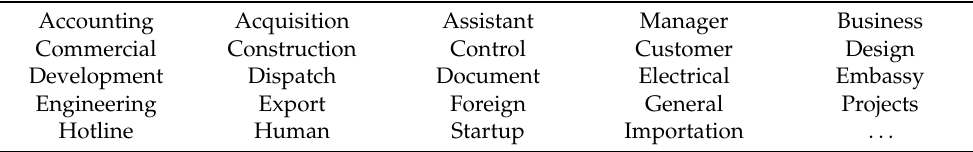
Examples of the words being picked from the “Label” attribute, for computer word